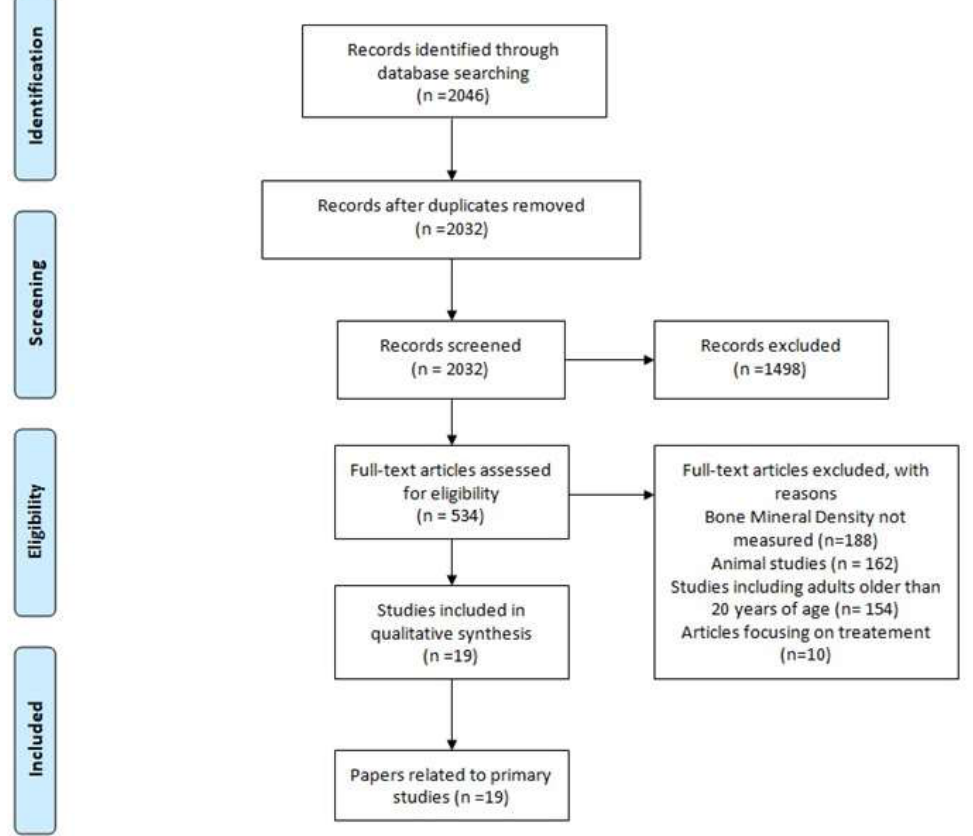
Figure 1. Flow chart of the literature review process.